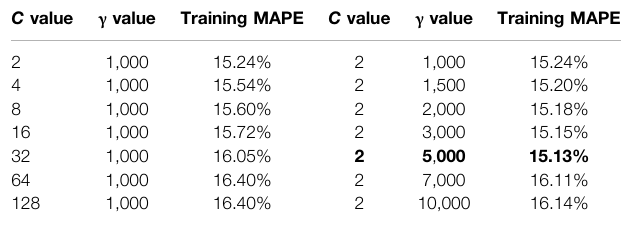
TABLE 4 | SVM parameter settings and training error.